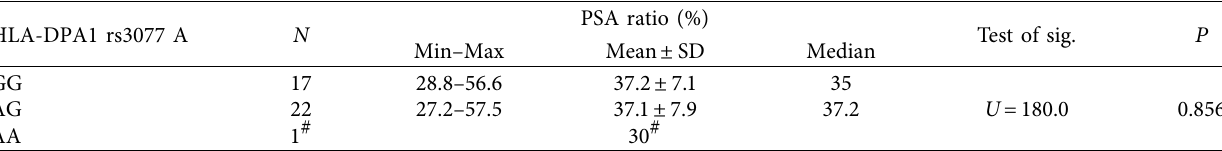
Table 3: Relation between PSA ratio and different genotypes in PCa group ( n �